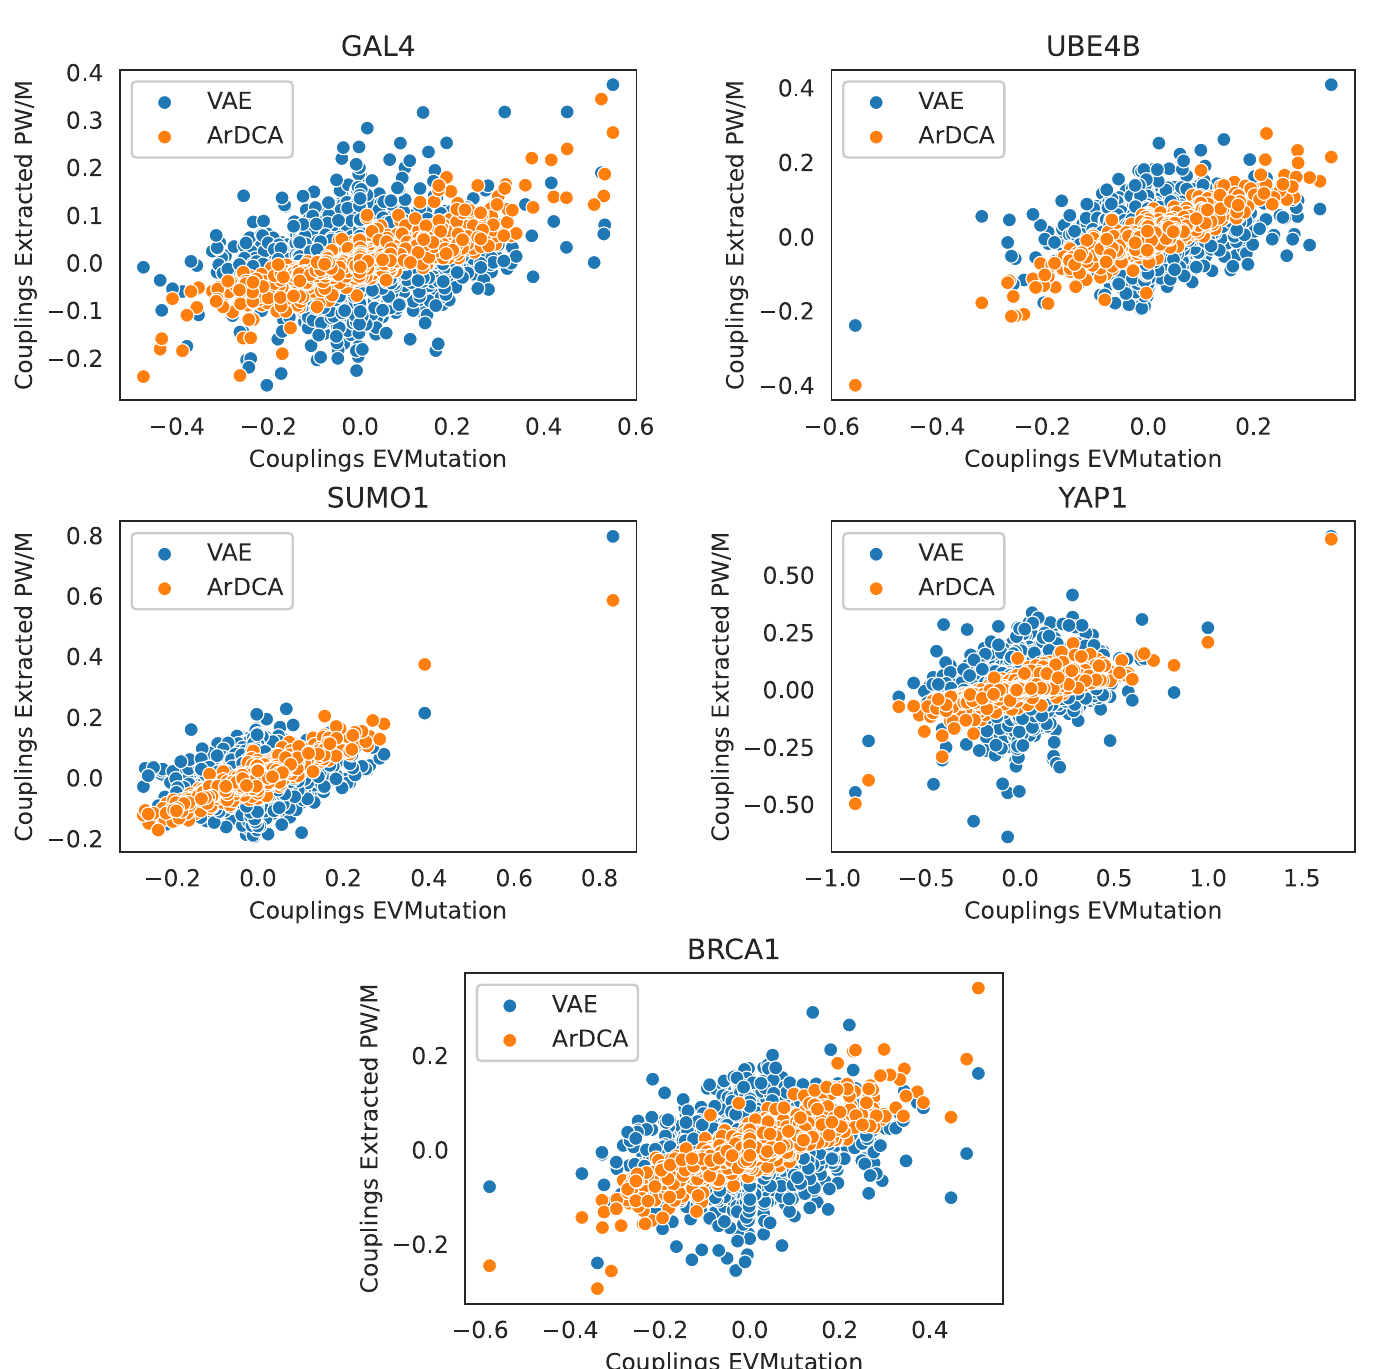
Fig 8. EVMutation couplings versus Couplings from PW/M Models extracted from ArDCA and VAE. Shown are scatterplots for all datasets of couplings as obtained from EVMutation after training versus couplings from pairwise models extracted using sequences sampled from the original model distribution, for ArDCA and VAE (weight decay setting 0.01). Given that the number of couplings is very large, we plot in all cases a subset of 5000 randomly chosen coupling pairs. Before plotting, all couplings were transformed to the zero-sum gauge.